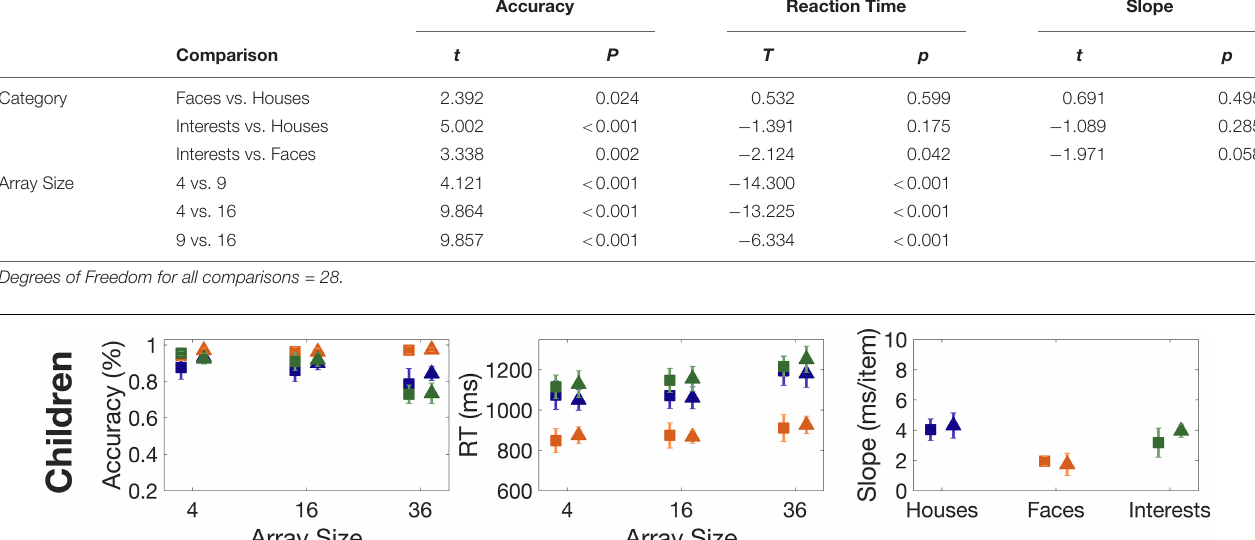
suggests that while children performed worse on the task than adults overall, both groups were affected by the increase in array sizes equally. There was also no main effect of diagnosis ( p = 0.558), and there was no interaction between diagnosis and category ( p =